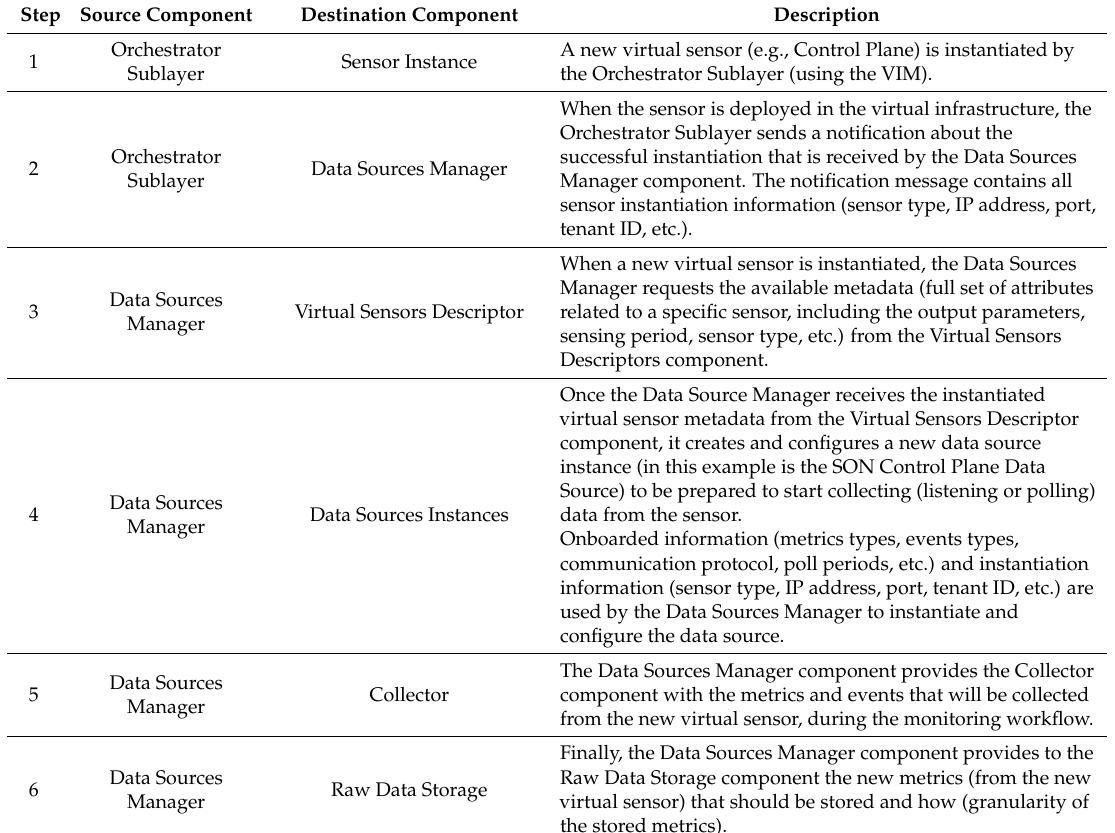
Table 6. Sensor Instantiation Workflow Steps.